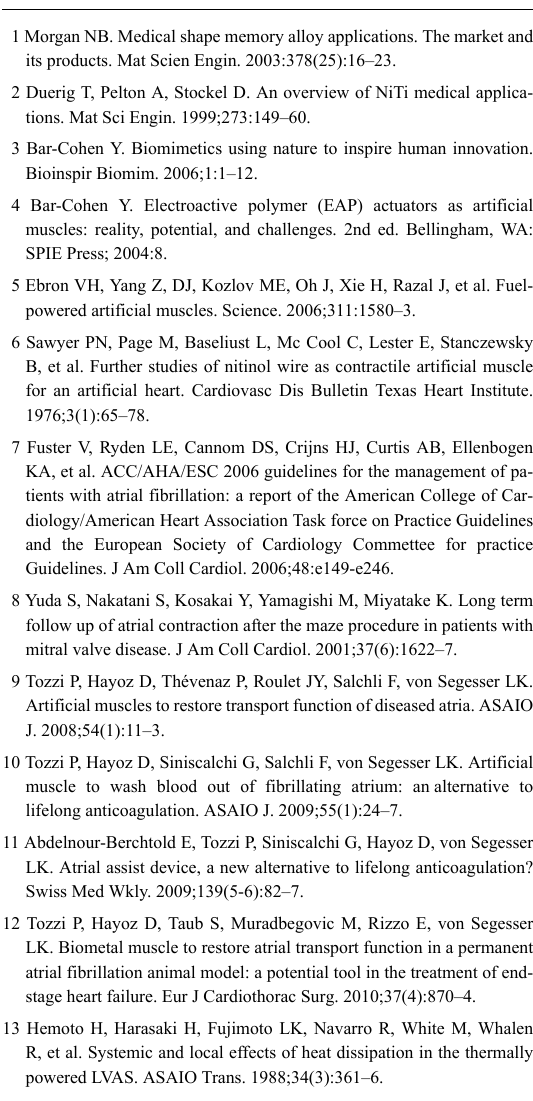
Table: Clinical applications of artificial muscle technology. Domain of